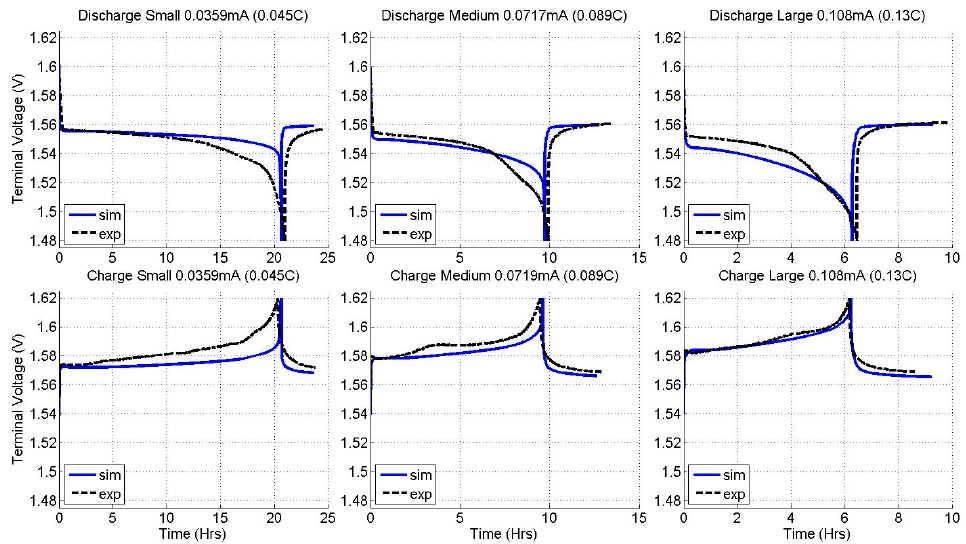
Figure 3. Experimental validation of terminal voltage of an LTO half-cell at 0.05 C, 0.1 C and 0.15 C cycles.